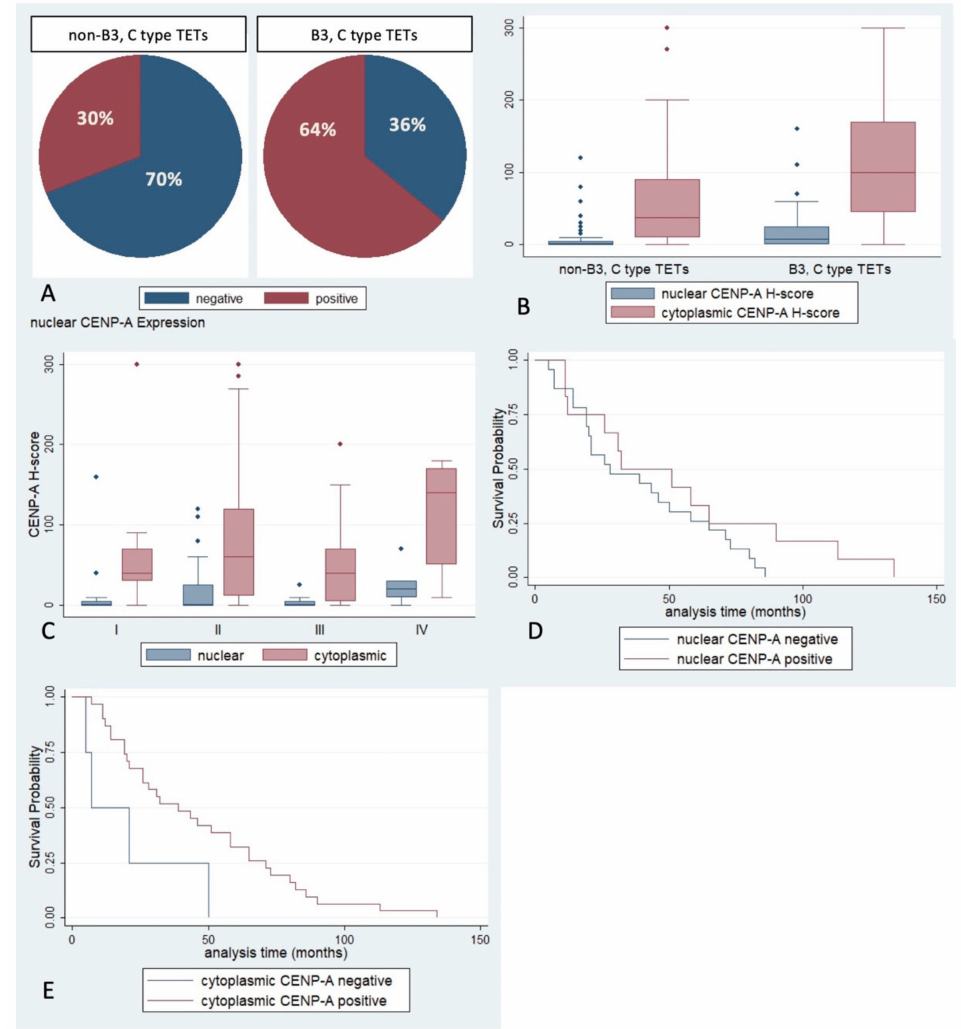
Figure 3. ( A ) Positivity rate of nuclear CENP-A in epithelial cells according to the WHO histological subtype (Fischer’s exact test, p = 0.01). ( B ) Schematic representation of the associations between CENP-A H-score and WHO subtype (Mann–Whitney U test, p = 0.01 for cytoplasmic and p = 0.02, for nuclear). ( C ) CENP-A H-score expression according to Masaoka–Koga stage (Mann–Whitney U test, IV vs. I/II/III, p = 0.04 for nuclear, p > 0.10 for cytoplasmic). ( D , E ) Kaplan–Meier survival rates according to nuclear ( D ) and cytoplasmic ( E ) CENP-A positivity (log-rank test, p > 0.10 for nuclear and p = 0.03 for cytoplasmic). Small diamonds in ( B , C ) correspond to